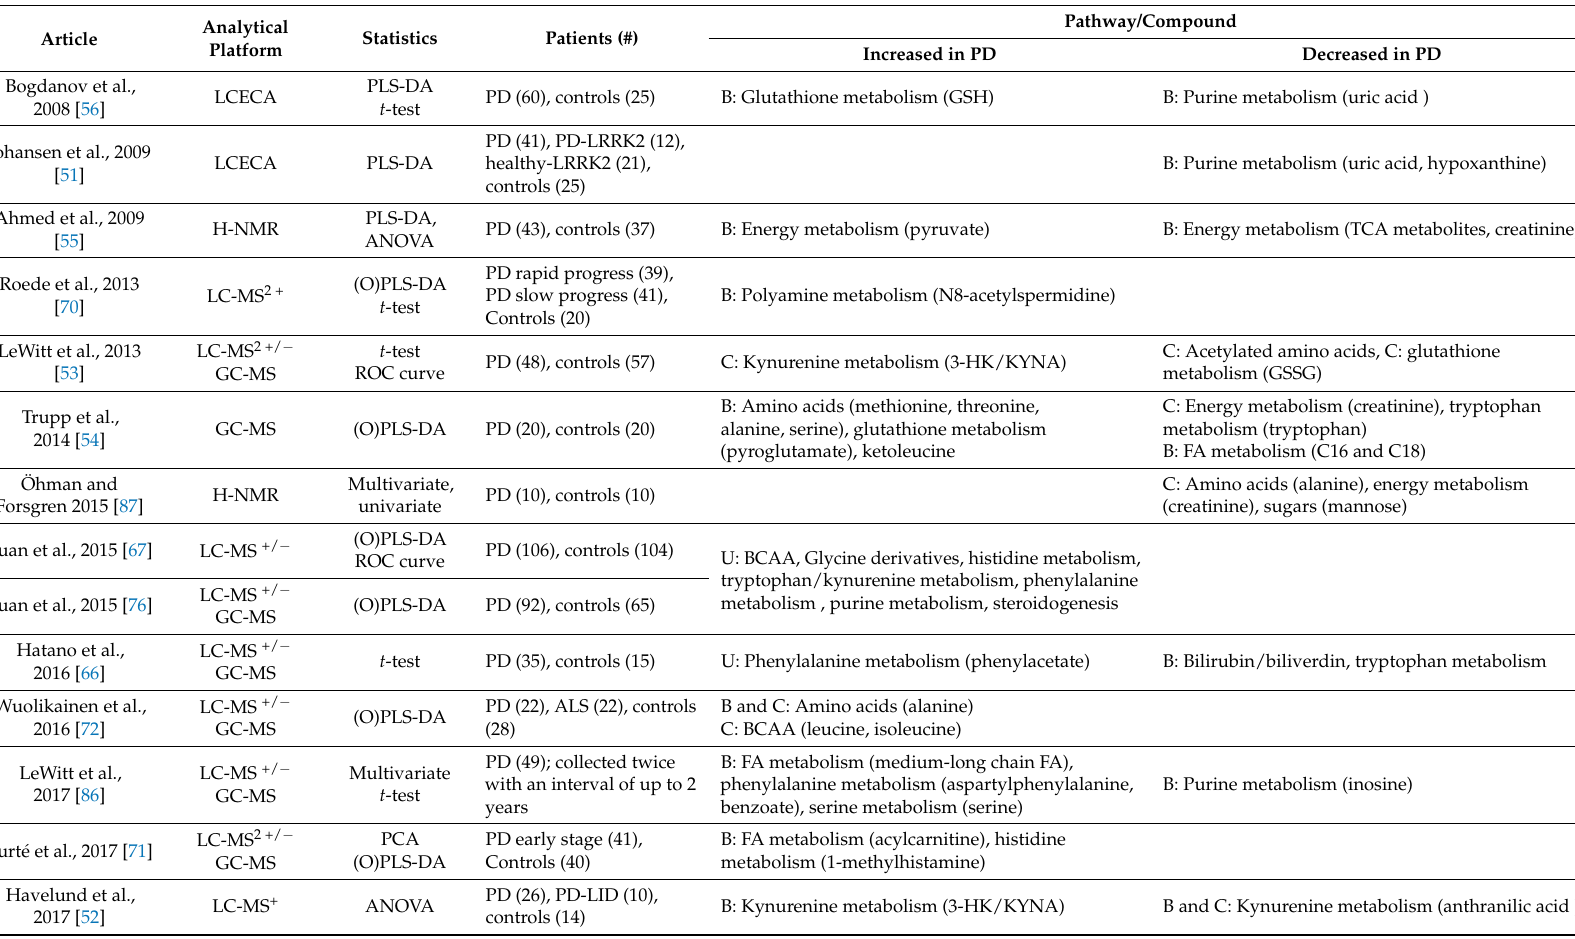
Table 1. Overview of metabolomic studies in PD clinical research. LCECA, liquid chromatography electrochemistry array; LID, L-DOPA-induced-dyskinesia; BCAA, branched chain amino